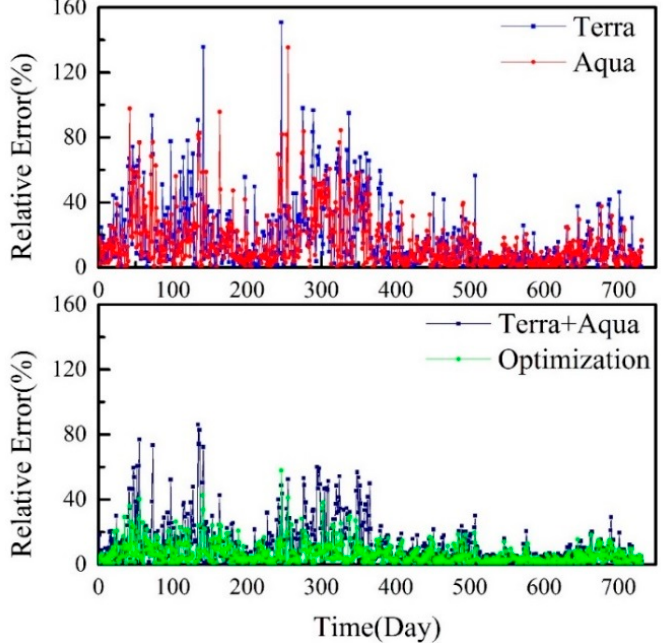
Figure 7. Relative errors of MODIS/Terra, MODIS/Aqua, the combination of MODIS/Aqua and MODIS/Terra, and the optimization results at station A1.